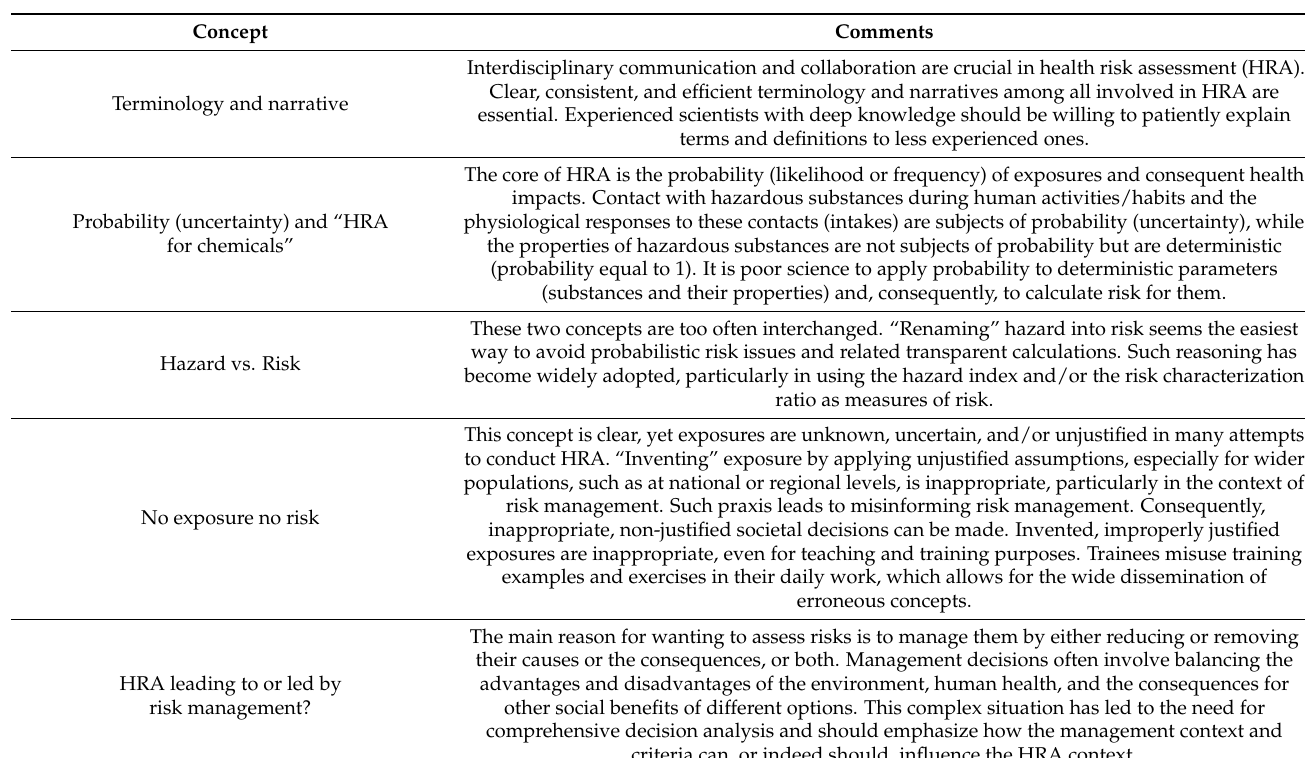
Table 1. Selected HRA concepts and comments on recognized